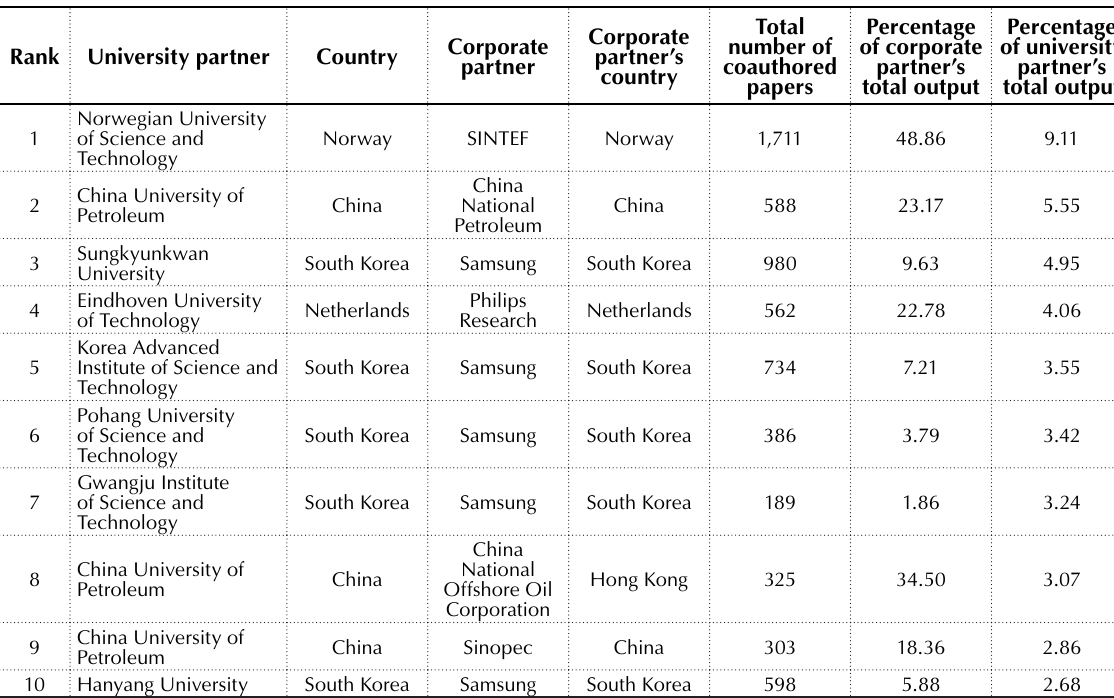
Table 1. Most prolific university-corporate